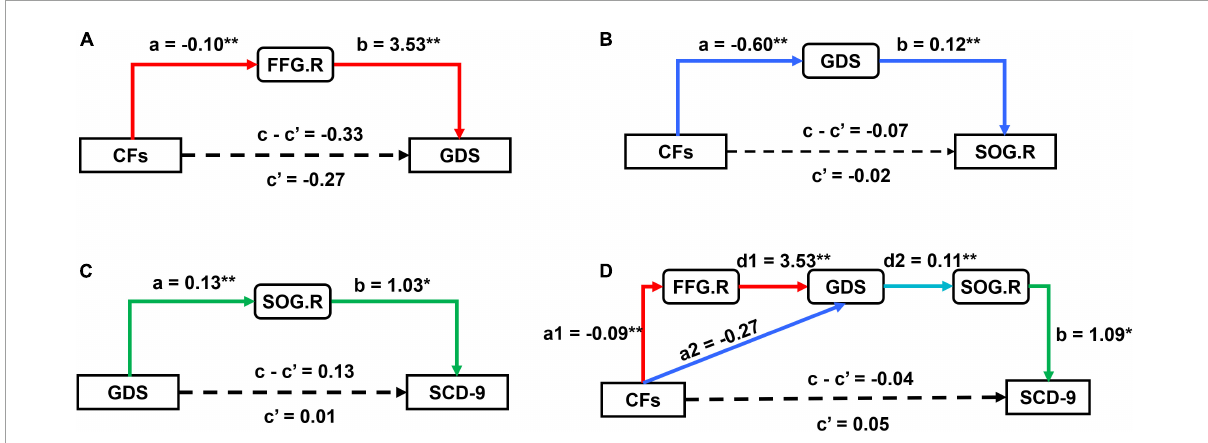
FIGURE4 Results of mediation analysis between CFs, GDS, SCD-9, FFG.R, and SOG.R. (A) The model (CFs → FFG.R → GDS) exhibited a substantial (and complete) mediation; (B) the model (CFs → GDS → SOG.R) exhibited a substantial (and complete) mediation; (C) the model (GDS → SOG.R → SCD-9) exhibited a substantial (and complete) mediation; (D) the model (CFs → FFG.R → GDS → SOG.R → SCD-9) and (CFs → GDS → SOG.R → SCD-9) both exhibited a substantial (and complete) mediation; other models are reported in Supplementary Figures 1–3 . (* p < 0.05, ** p < 0.01).